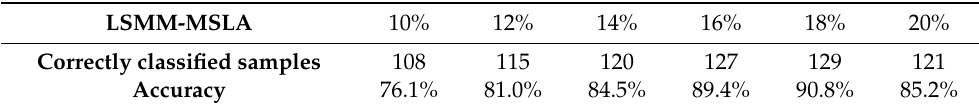
Table 4. Extraction accuracy of the ADL.